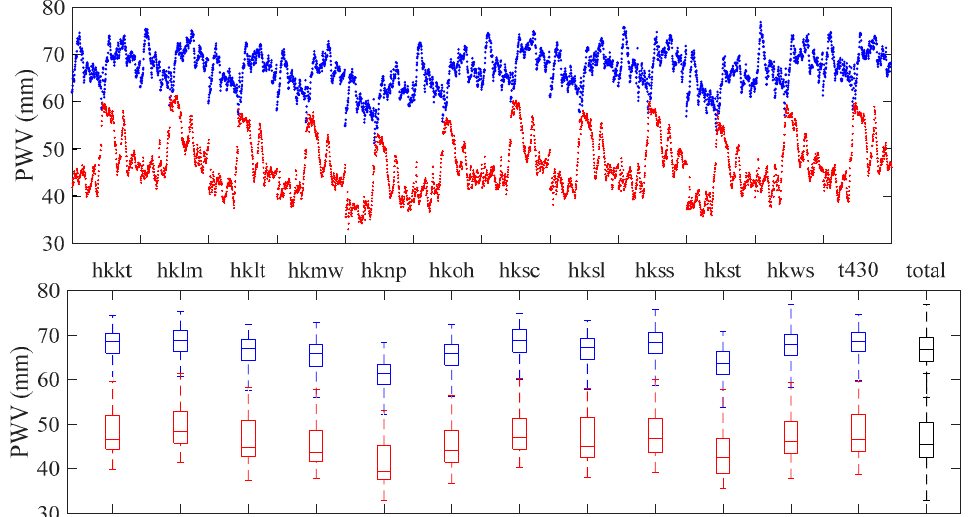
Figure 3. Scatter ( upper ) and boxplot ( lower ) of the observed PWV at each station during the period of rainless and rainy days. Blue for the rainy condition and red for the rainless condition.